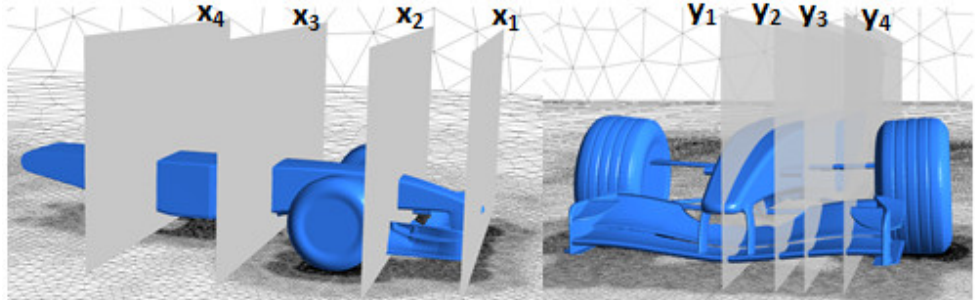
Figure 7. Characteristic plans considered for the fluid dynamics analysis in the x, y direction.